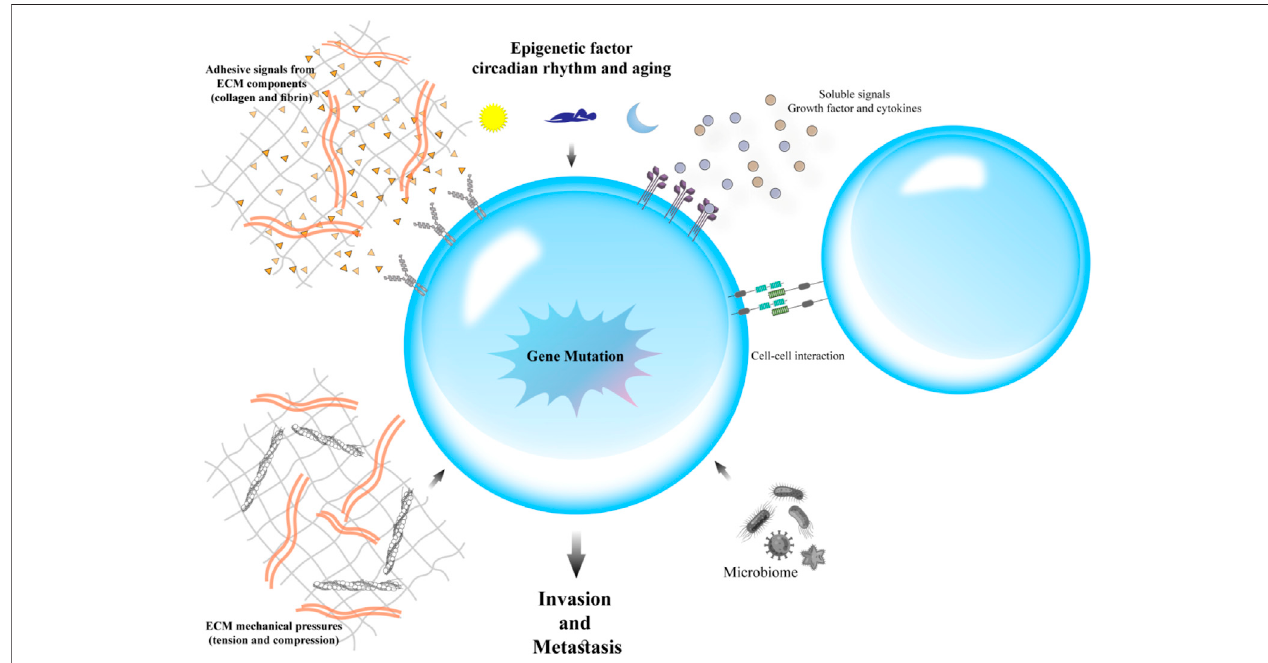
FIGURE 2 | Factors involved in cancer metastasis: Several molecular and cellular factors contribute to invasion and metastasis activation, including epigenetic factors, adhesive signals of extracellular matrix (ECM) components, ECM mechanical pressures, cell – cell interactions, soluble signals, and the intratumoral microbiota.